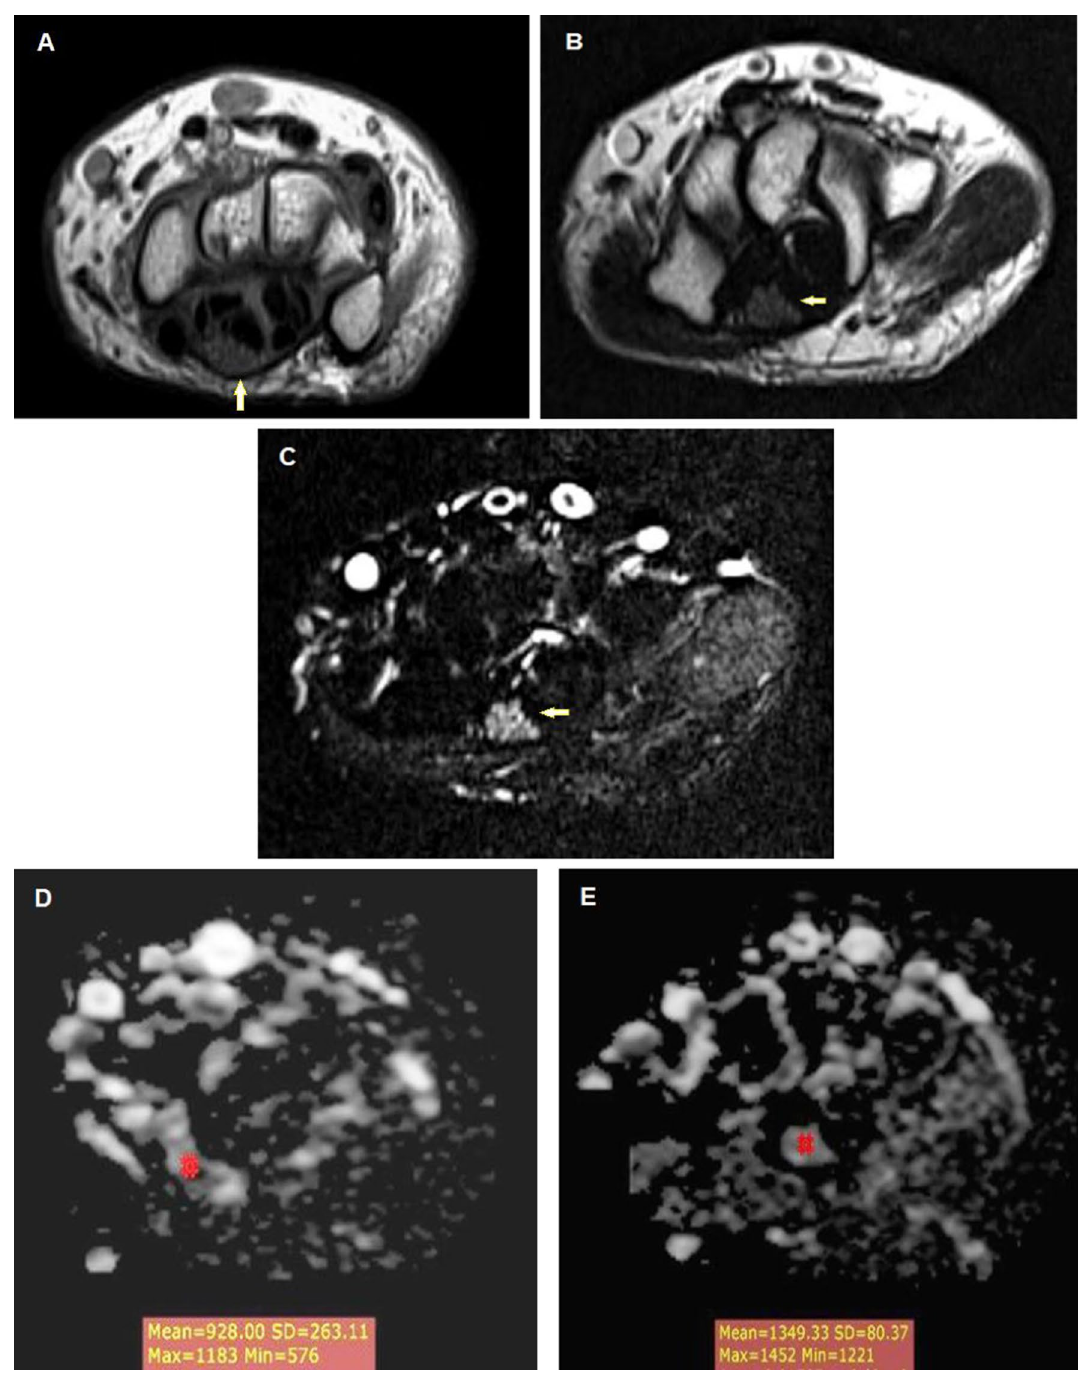
Fig. 2 A–E images: A 23-year-old female patient has presented with right hand pain, tingling, numbness mainly at the thumb, index and middle fingers, and radial half of the ring finger since 8 months. By nerve conduction studies, the case was diagnosed as severe carpal tunnel syndrome. A Axial T1, and B Axial T2-weighted MR images show manifest thickening of the examined median nerve with bowing of the flexor retinaculum (yellow arrows), C T2-SPAIR image shows increased signal intensity of the median nerve (yellow arrow), D ADC map showing low mean ADC value of MN at DRUJ (0.92 10 –3 mm 2 /s), and E ADC map showing increase of mean ADC value at pisiform (1.3 × consistent with carpal tunnel